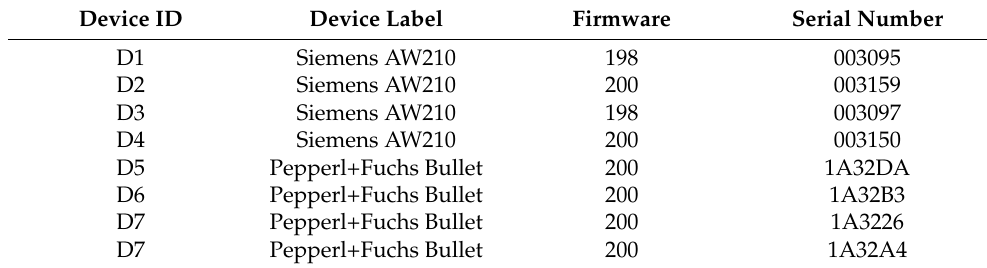
Figure 2. Illustration of pre-fingerprint generation processing effects on a representative Wire- lessHART response. The final down-converted bandpass filtered signal is used for subsequent time domain DNA (TdDna) and Gabor transform DNA (GtDna) generation. Table 1. Selected details for N Dev = 8 WirelessHART adapters used for demonstration.